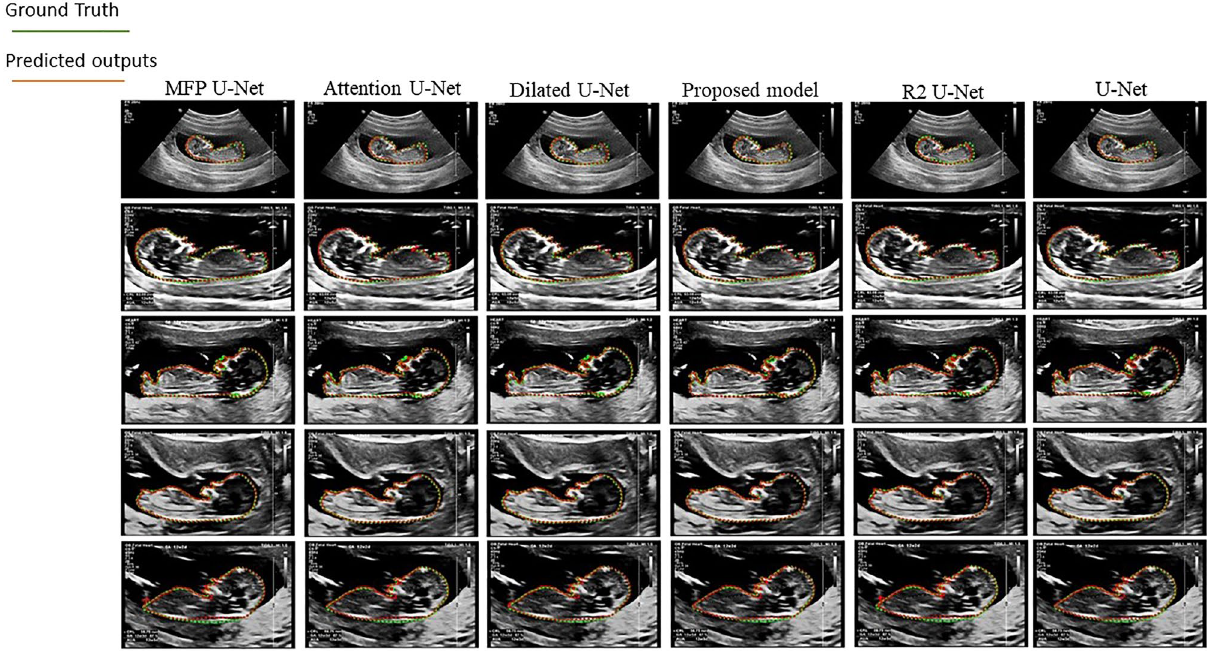
Figure 8. Samples of CRL segmentation achieved by the proposed model in comparison with other U-Net- based models.